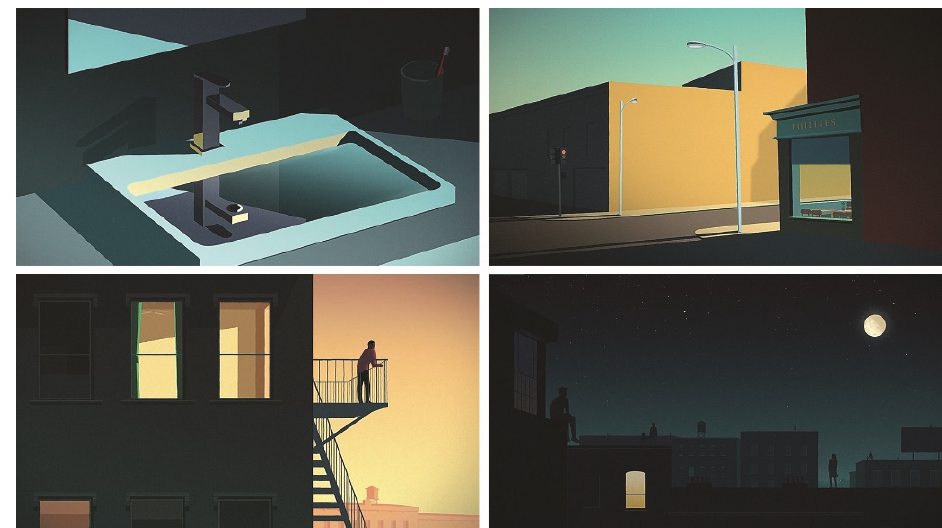
Figure 1. Illustration of four representative frames of the scene. Using Reaper 6.29, we created five versions of the short movie—varying under the five experimental conditions—with the video accompanied respectively by a happy piece ( Appalachian spring — VII: doppio movimento) by A. Copland), a sad cello melody accompa- nied by a piano, ( After Celan by D. Darling and K. Bjørnstad), a frightening track from the Original Motion Picture Soundtrack of the film Proxy ( Murder by the Newton Brothers), a relaxing piece specifically composed to control anxiety [70], or by no music at all (i.e., control condition). This method allowed us to present all the possible combinations of valence and arousal (Table 2). Table 2. Soundtracks’ emotional valence and arousal. Track Emotion Valence Arousal Appalachian spring (VII: doppio movimento) [A. happiness Copland] After Celan [D. Darling and K. Bjørnstad]